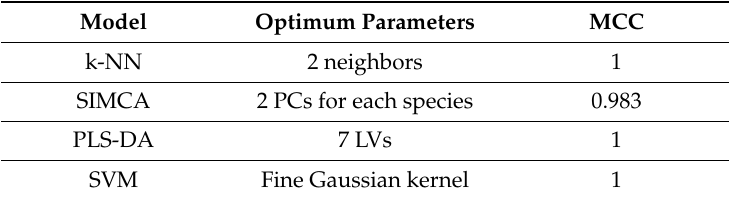
Table 5. Calibration of the models depicting optimum parameters and performances evaluated with a 10-fold cross-validation procedure.